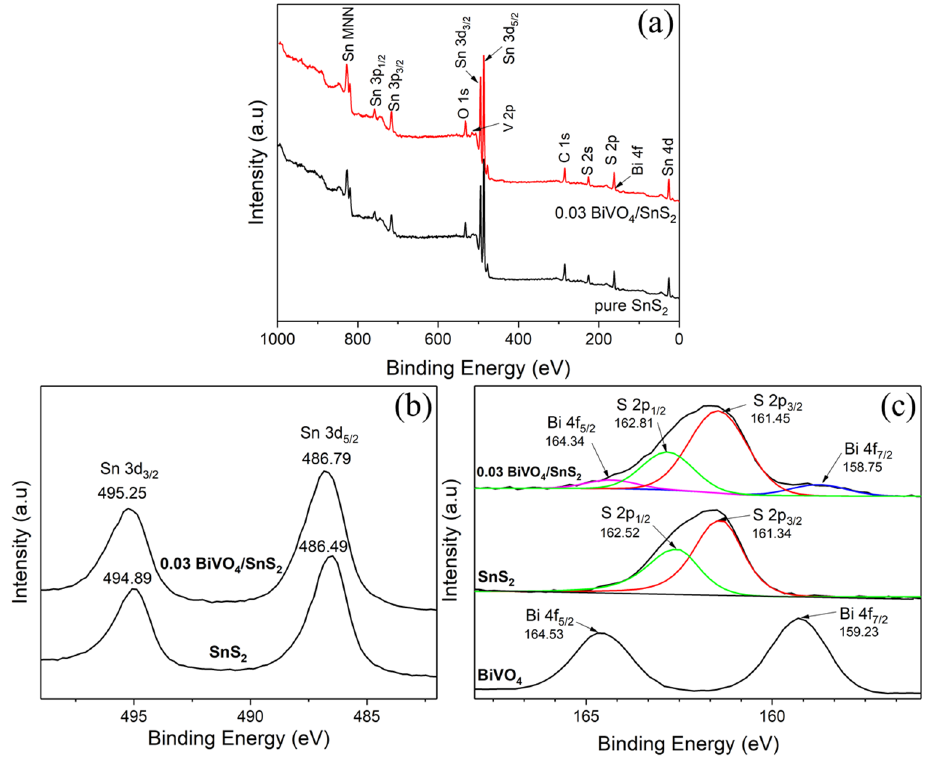
Figure 5. ( a ) XPS survey spectra of 0.03 BiVO 4 / SnS 2 and pure SnS 2 and high-resolution XPS spectra of ( b ) Sn 3d orbital and ( c ) Bi 4f and S 2p orbital.